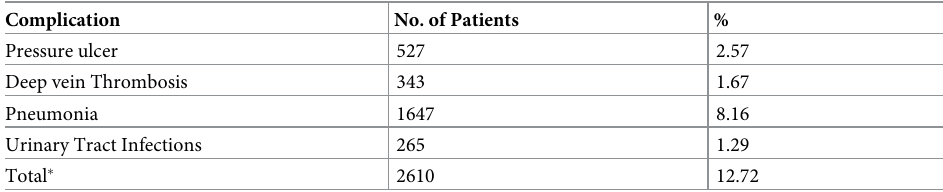
Table 2. Type of MCI in 20515 patients.